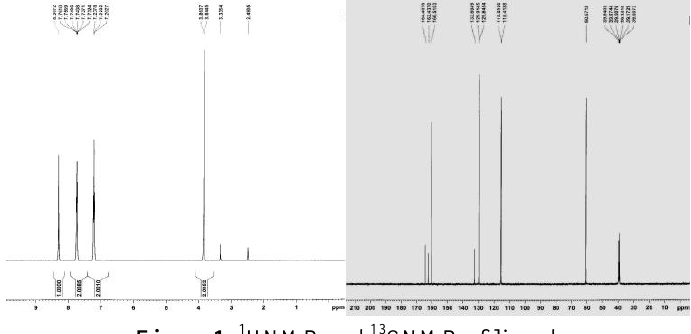
Figure 1. 1 HNMR and 13 CNMR of